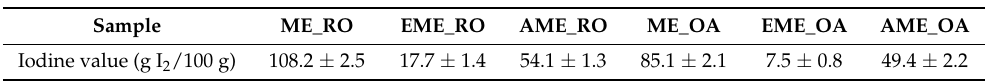
Table 3. Iodine values for intermediate products, and final bio-based monomers originated from RO and